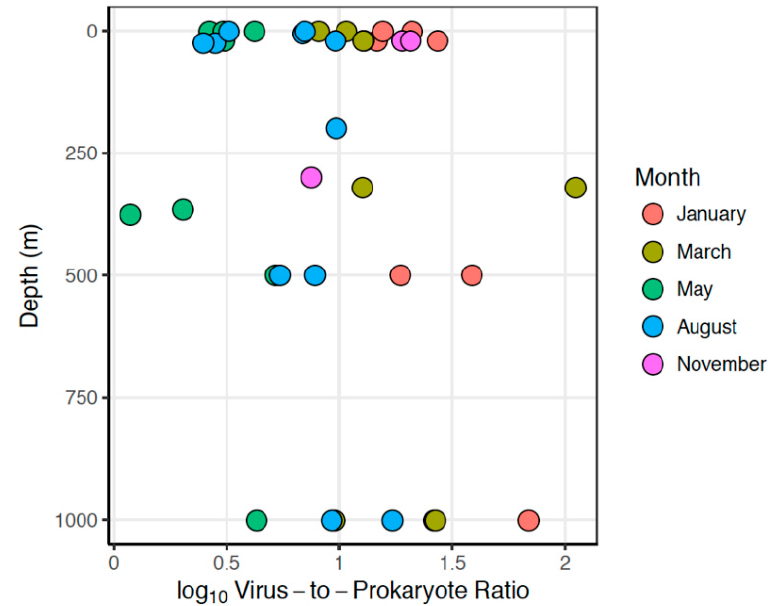
Figure 5. Virus-to-prokaryote ratios (VPRs). VPRs were calculated by dividing flow cytometry counts of small viruses (V1) by flow cytometry counts of heterotrophic prokaryotes (HPs). Depth (m) is shown on the y axis. Sampling months are represented with different colors.